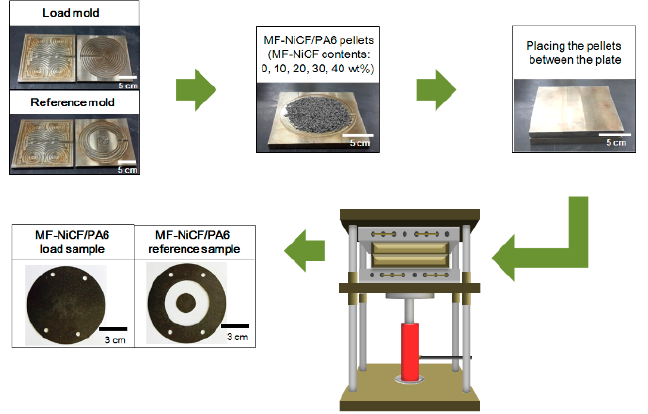
Figure 2. Compression molding process to prepare the load specimen and the reference specimen with various NiCF contents for EMI SE